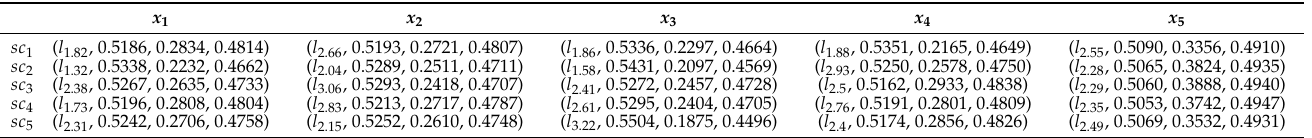
(cid:110) α PL / discr ij